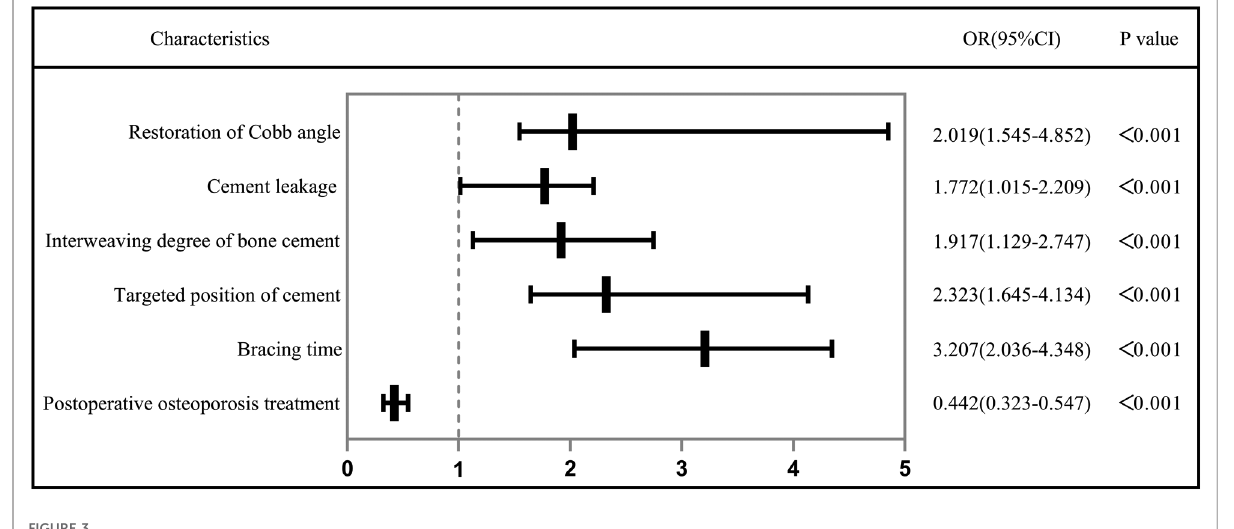
FIGURE 3 Risk factors of postoperative bone cement mass displacement.